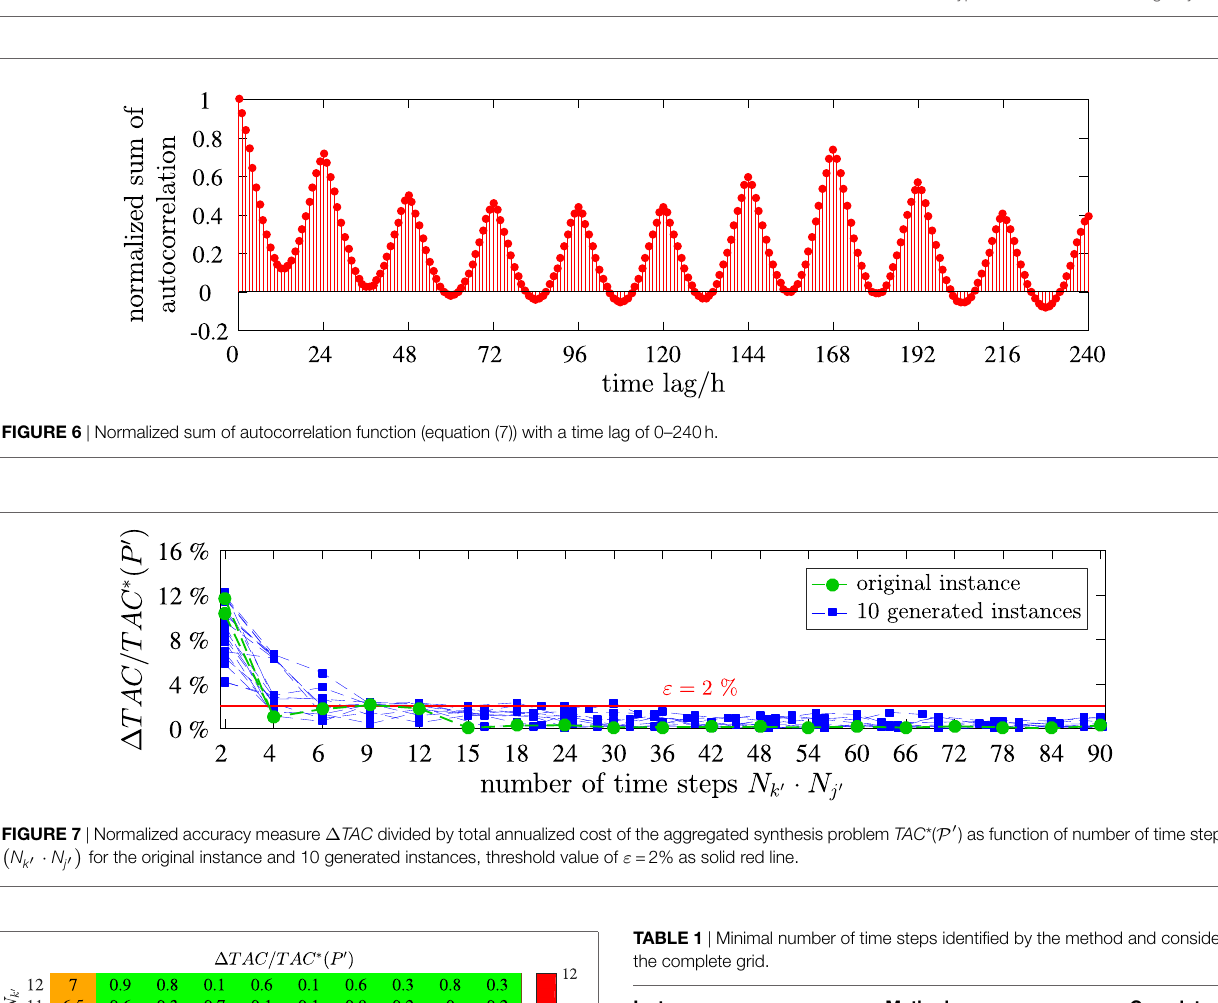
TABLE 1 | Minimal number of time steps identified by the method and considering the complete grid. Instance Method Complete grid